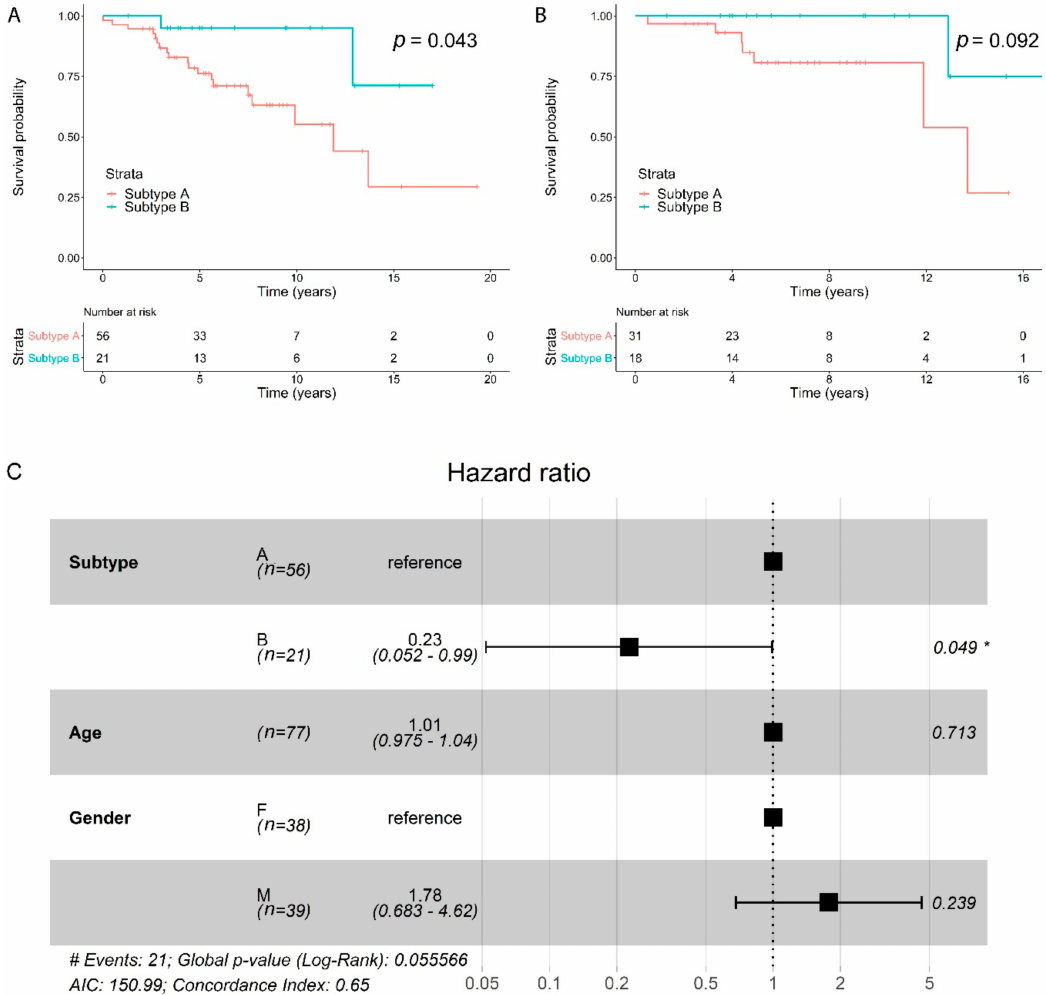
Figure 4. Survival analysis for the two subtypes, A and B. ( A ) Kaplan–Meier overall survival curve for all patients for which follow-up data were available with associated p -value from Cox proportional hazards analysis. ( B ) Kaplan–Meier overall survival curve for patients without distant metastasis at diagnosis with associated p -value from Cox proportional hazards analysis. ( C ) Cox proportional hazards model for subtype, age and gender (F, female; M, male). Hazards ratios with 95% confidence intervals and p -values are